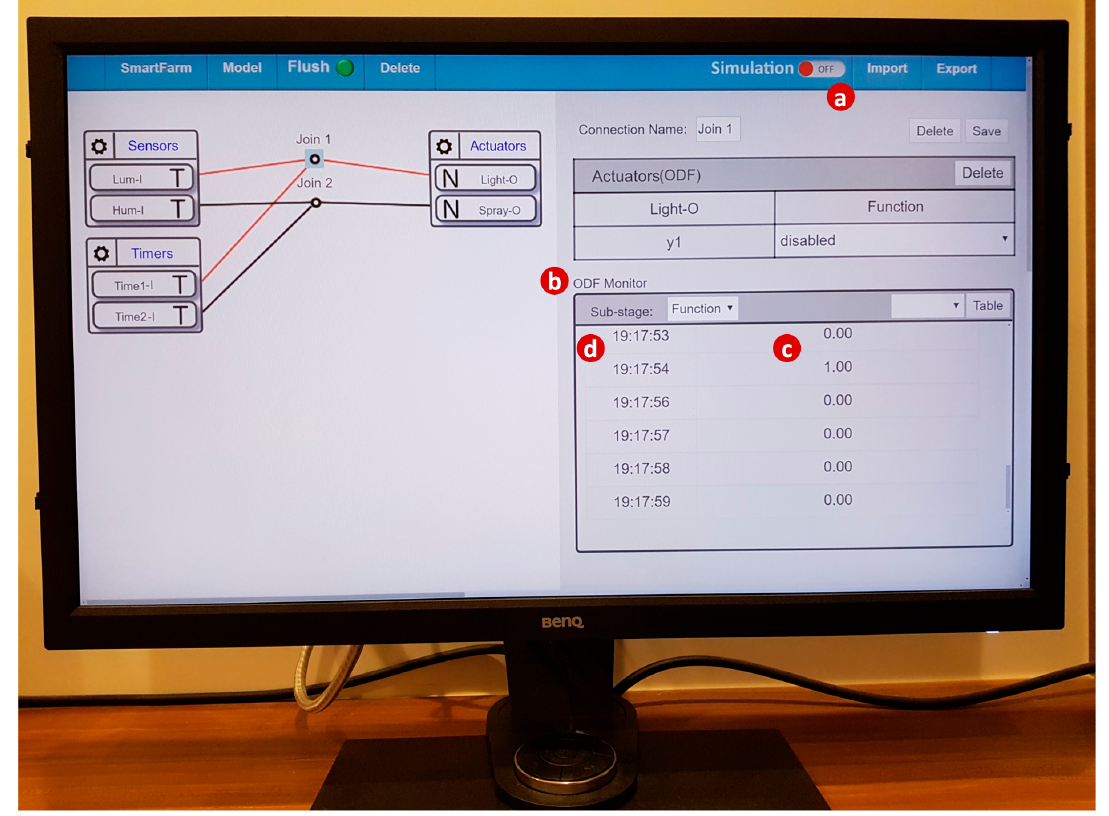
Figure 6. Web-based IoTtalk GUI (cont.).